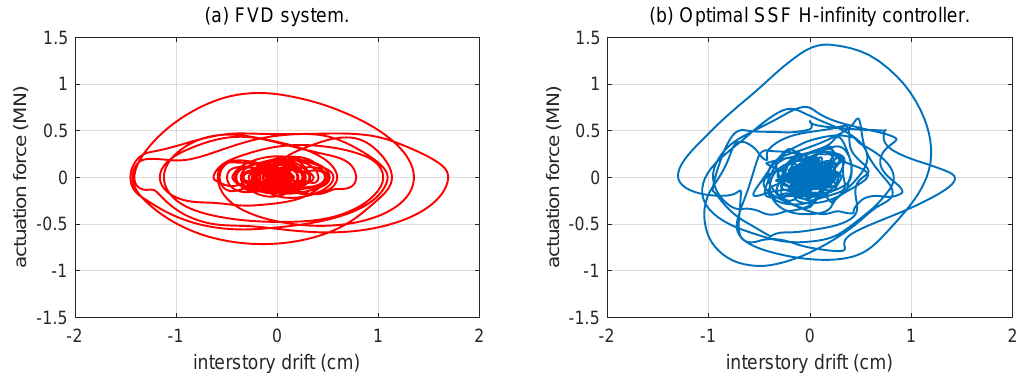
Figure 10. Plots of actuation force versus interstory drift in the 3rd story level corresponding to the FVD system and the optimal SSF H ∞ controller.